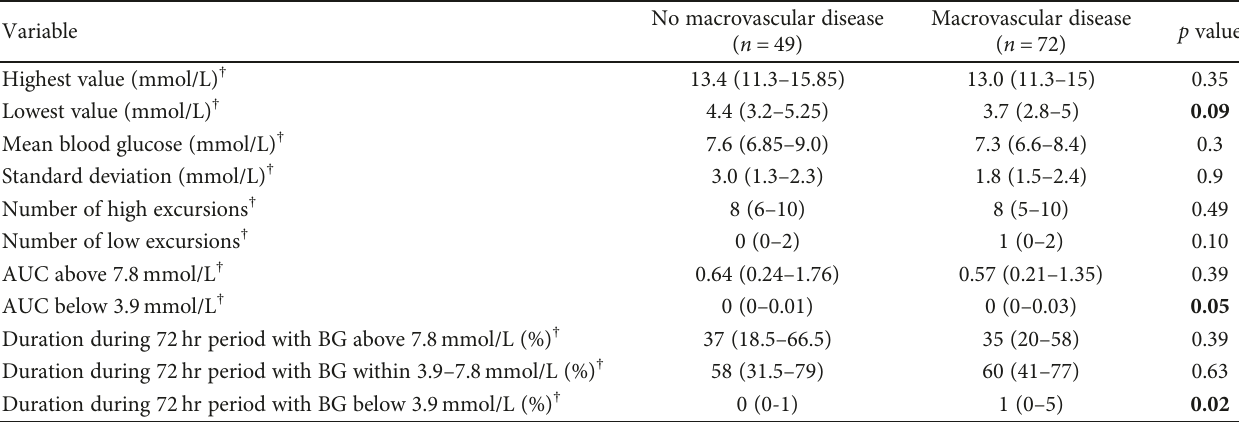
Table 5: Continuous glucose-monitoring fi ndings of subjects with and without macrovascular